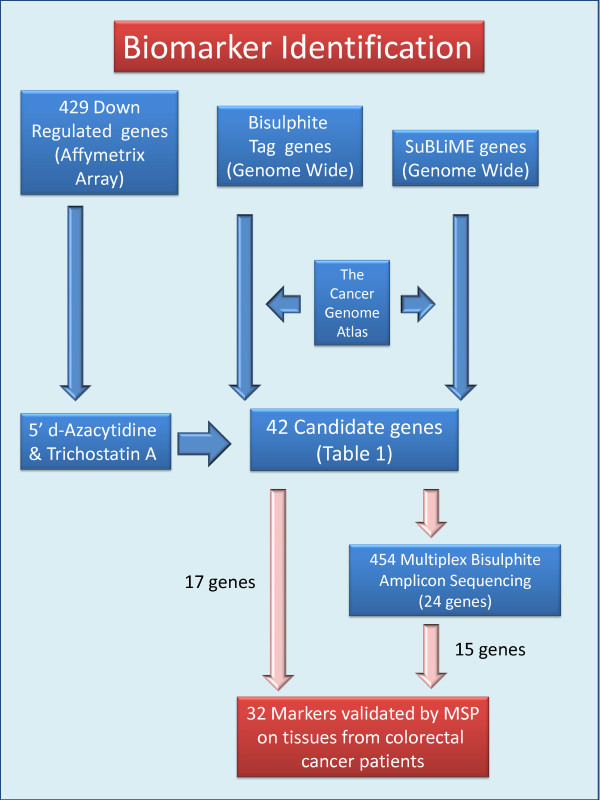
Biomarker discovery scheme. Detail discussed in text.